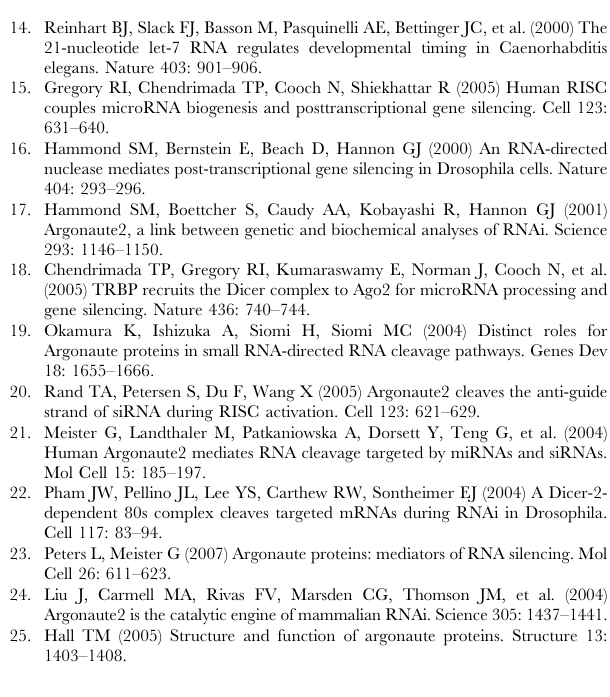
Figure S3 Using Ago2 IP enrichment and mRNA expression changes to assess computational target prediction methods. (A) Cumulative distributions of Ago2 IP enrichment in cells transfected with miR-1 relative to cells transfected with FLAG- Ago2 alone of several sets of mRNAs predicted to be targeted by miR-1. The 100 mRNAs containing 7mer 3 9 -UTR seed matches to miR-1 whose levels were most significantly downregulated due to the presence of miR-1 were the most enriched group (red). The 100 mRNAs whose levels were most significantly downregulated due to the presence of miR-1 irrespective of seed match sites were the next most enriched group in Ago2 IPs (dark green). The 100 mRNAs containing the lowest TargetScan 4.0 ‘‘cumulative context score’’ were the next most enriched group (blue). TargetScan 3.0 (274, magenta) and PicTar 5way predictions (97, orange) were the next most enriched groups. The 100